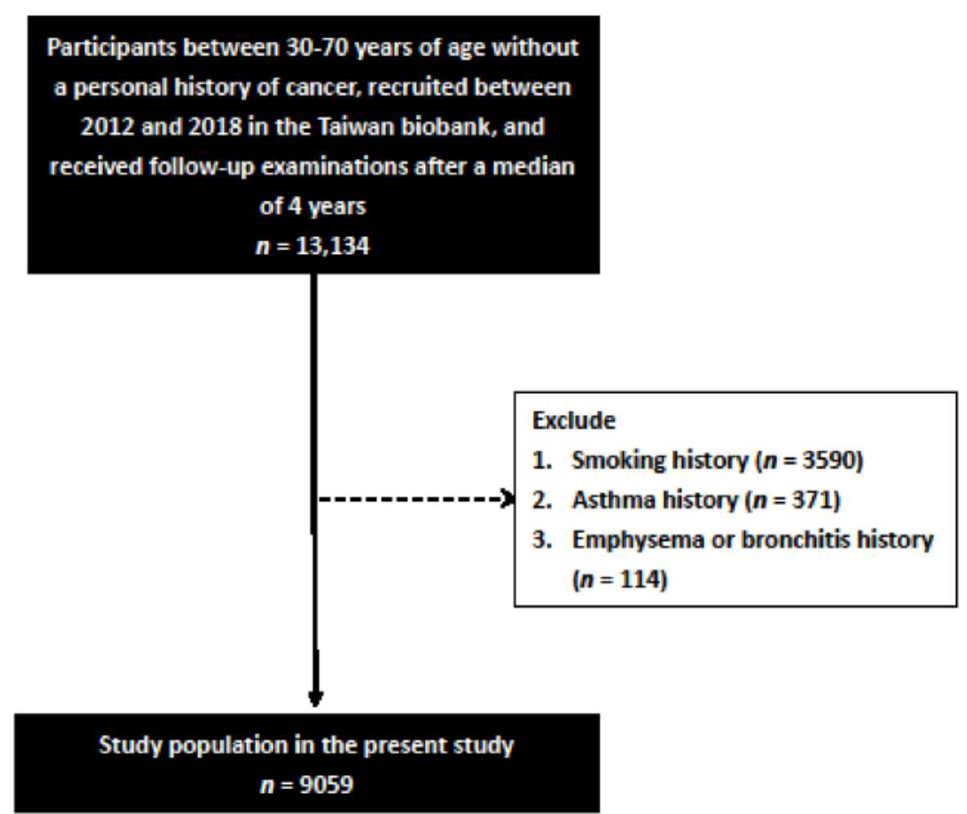
Figure 1. Flowchart of study population.